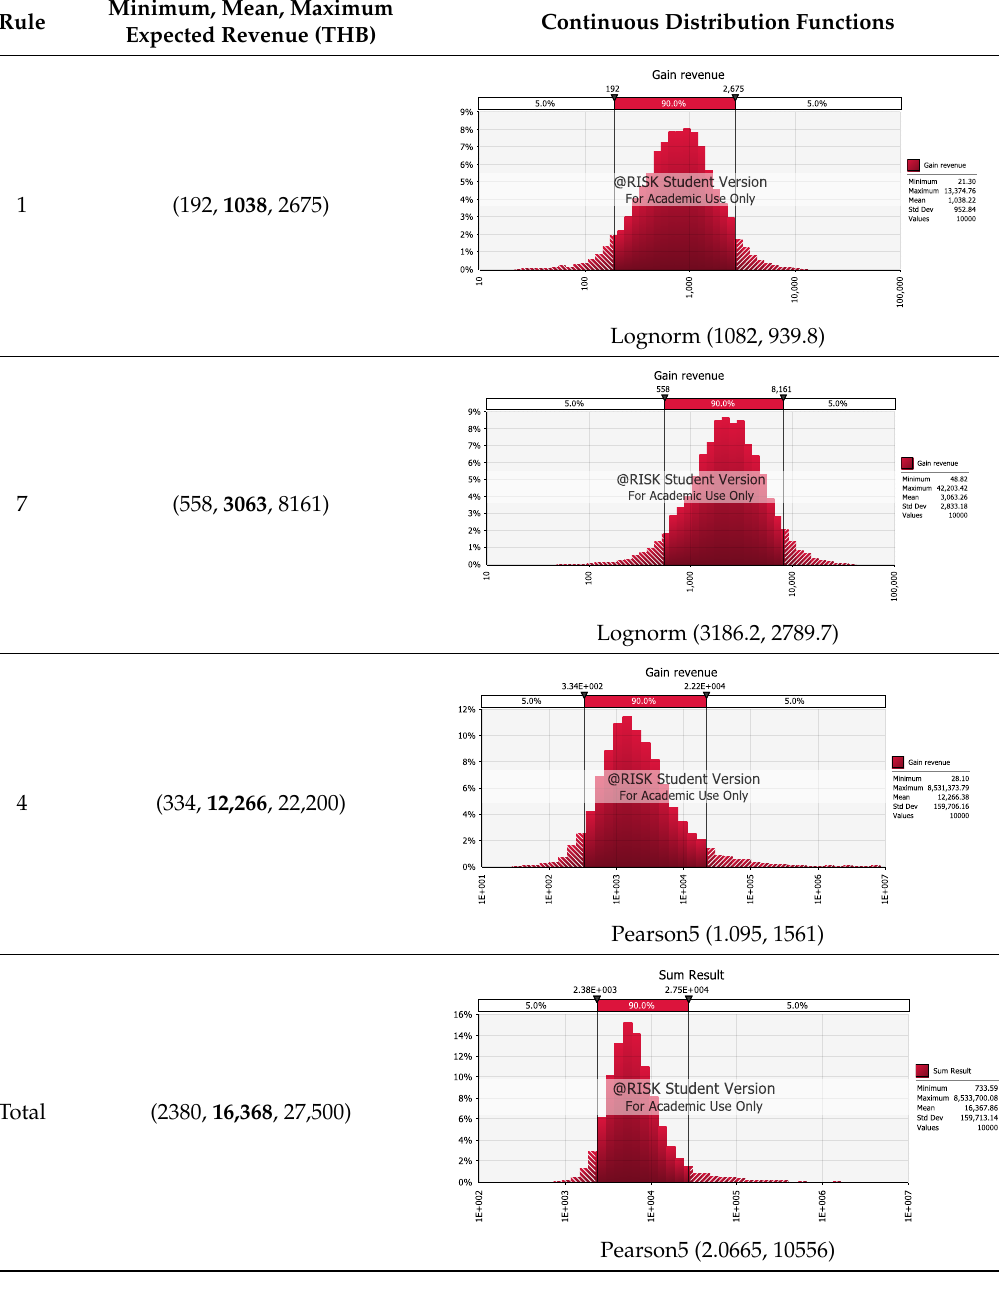
Table 9. Obtained minimum, mean, and maximum expected revenue (THB) within 90% confidence level using MC modeling of Rules 1, 7, 4, and the total.